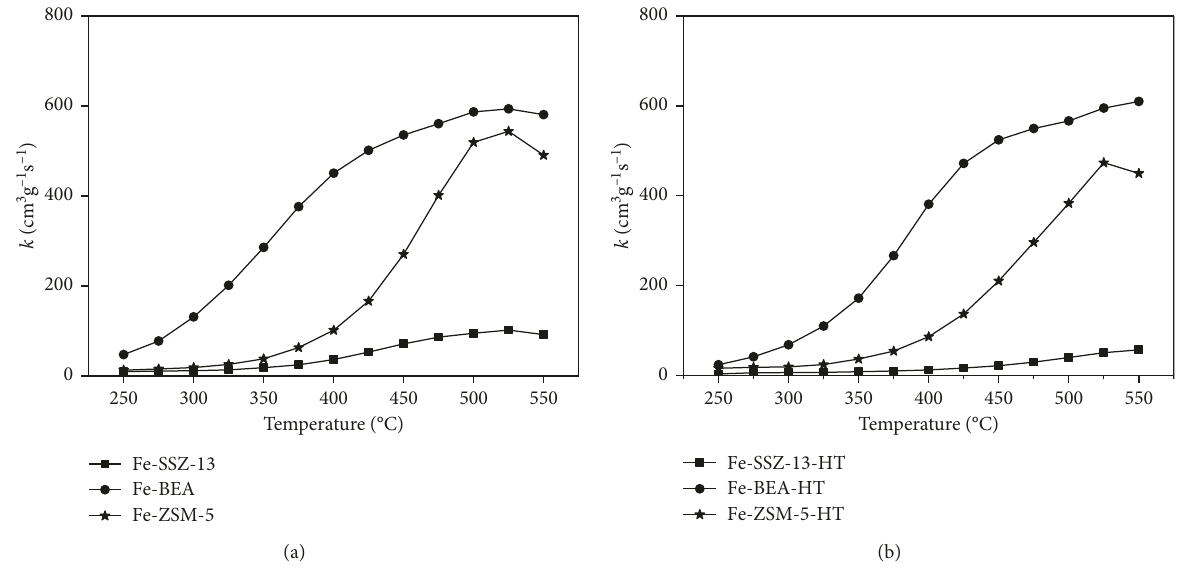
Figure 5: SCR activity of (a) fresh and (b) hydrothermally treated Fe-zeolites.